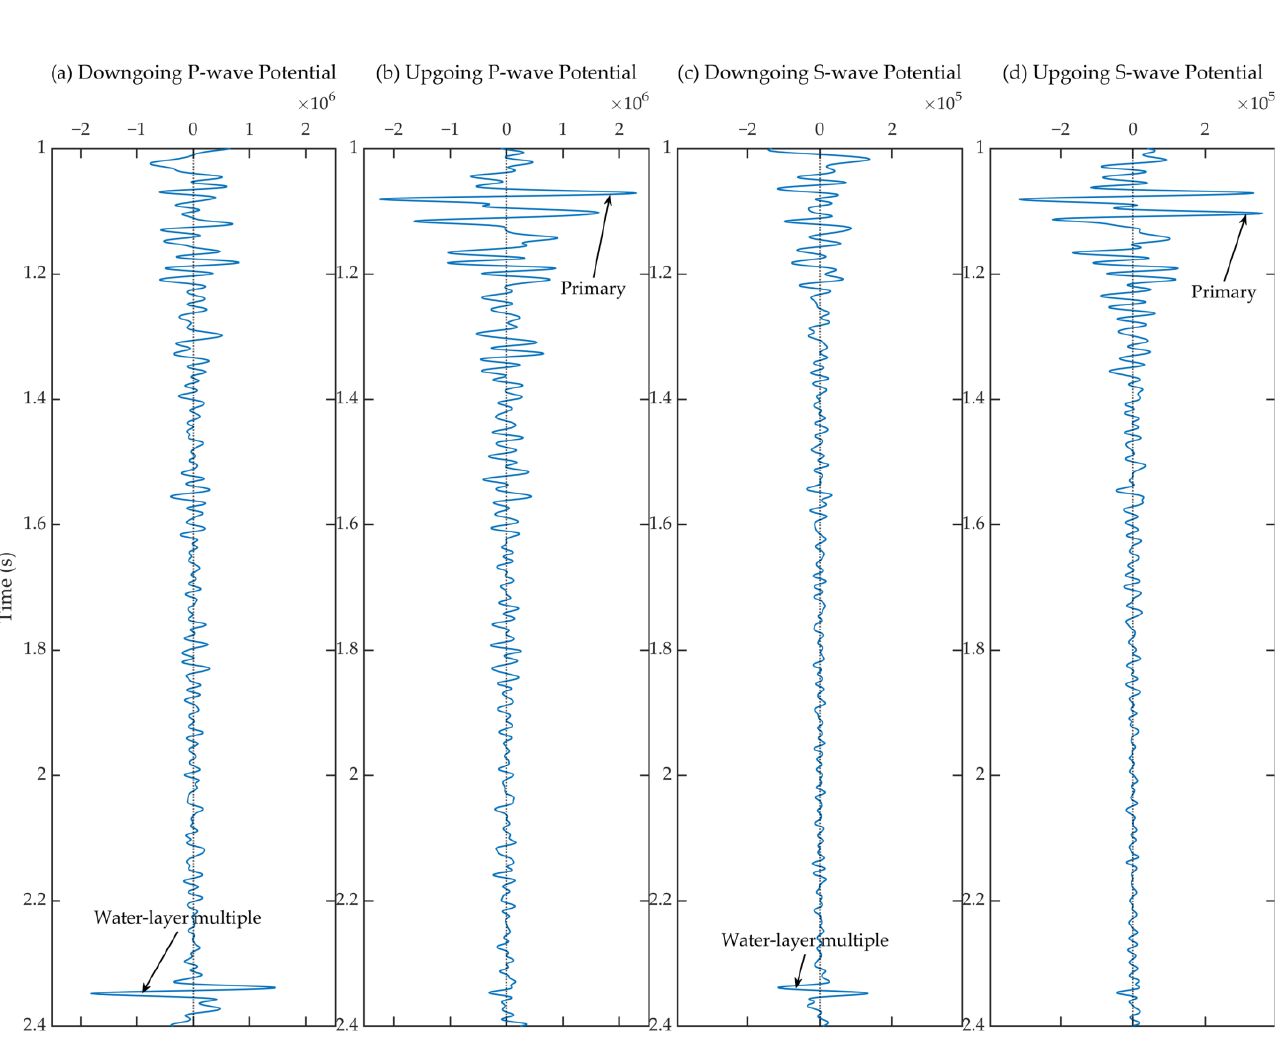
Figure 22. One-trace samples (the 300th trace, about 612.5 m in offsets) from the ( a ) downgoing P-potential, ( b ) upgoing P-potential, ( c ) downgoing S-potential, and ( d ) upgoing S-potential decom- posed just below the seafloor using our composite calibration method with errored vertical velocity data. No evident degradation in the results has been observed.